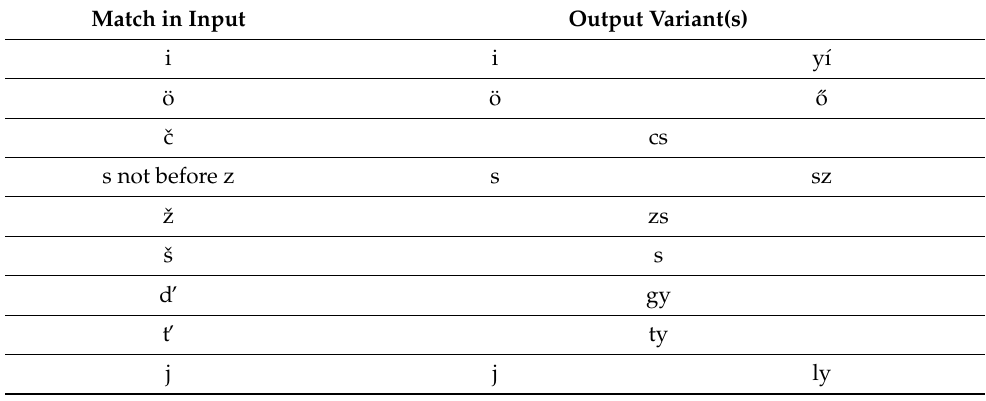
Figure 1. Transcription of an example placename using the developed system. The transcription rules are applied in the specified order from left to right; solid black arrows indicate where the specific rule matched; if that results in variant expansions, the arrows bifurcate. The output variants at the right side (after applying all of the rules from the ruleset) are tried top to bottom until one of them—in red—produces a match to the gazetteer. Duplicate variants from the bottom of the variant list are eliminated. Source: our own research. Table 1. The transcription rules for Hungarian placenames. Source: own